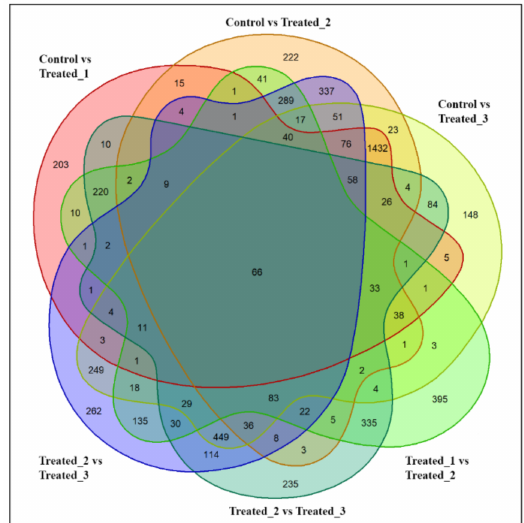
Figure 2. LC-MS Total ion chromatogram of A. polystachya seedling under control and all SA treatment conditions.